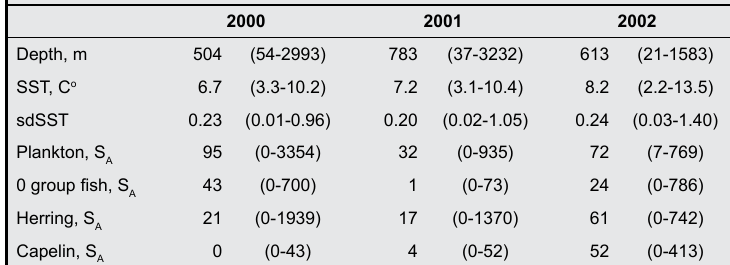
Table 1. Mean (minimum-maximum) values of habitat and prey variables of cruise line seg- ments with observer activity